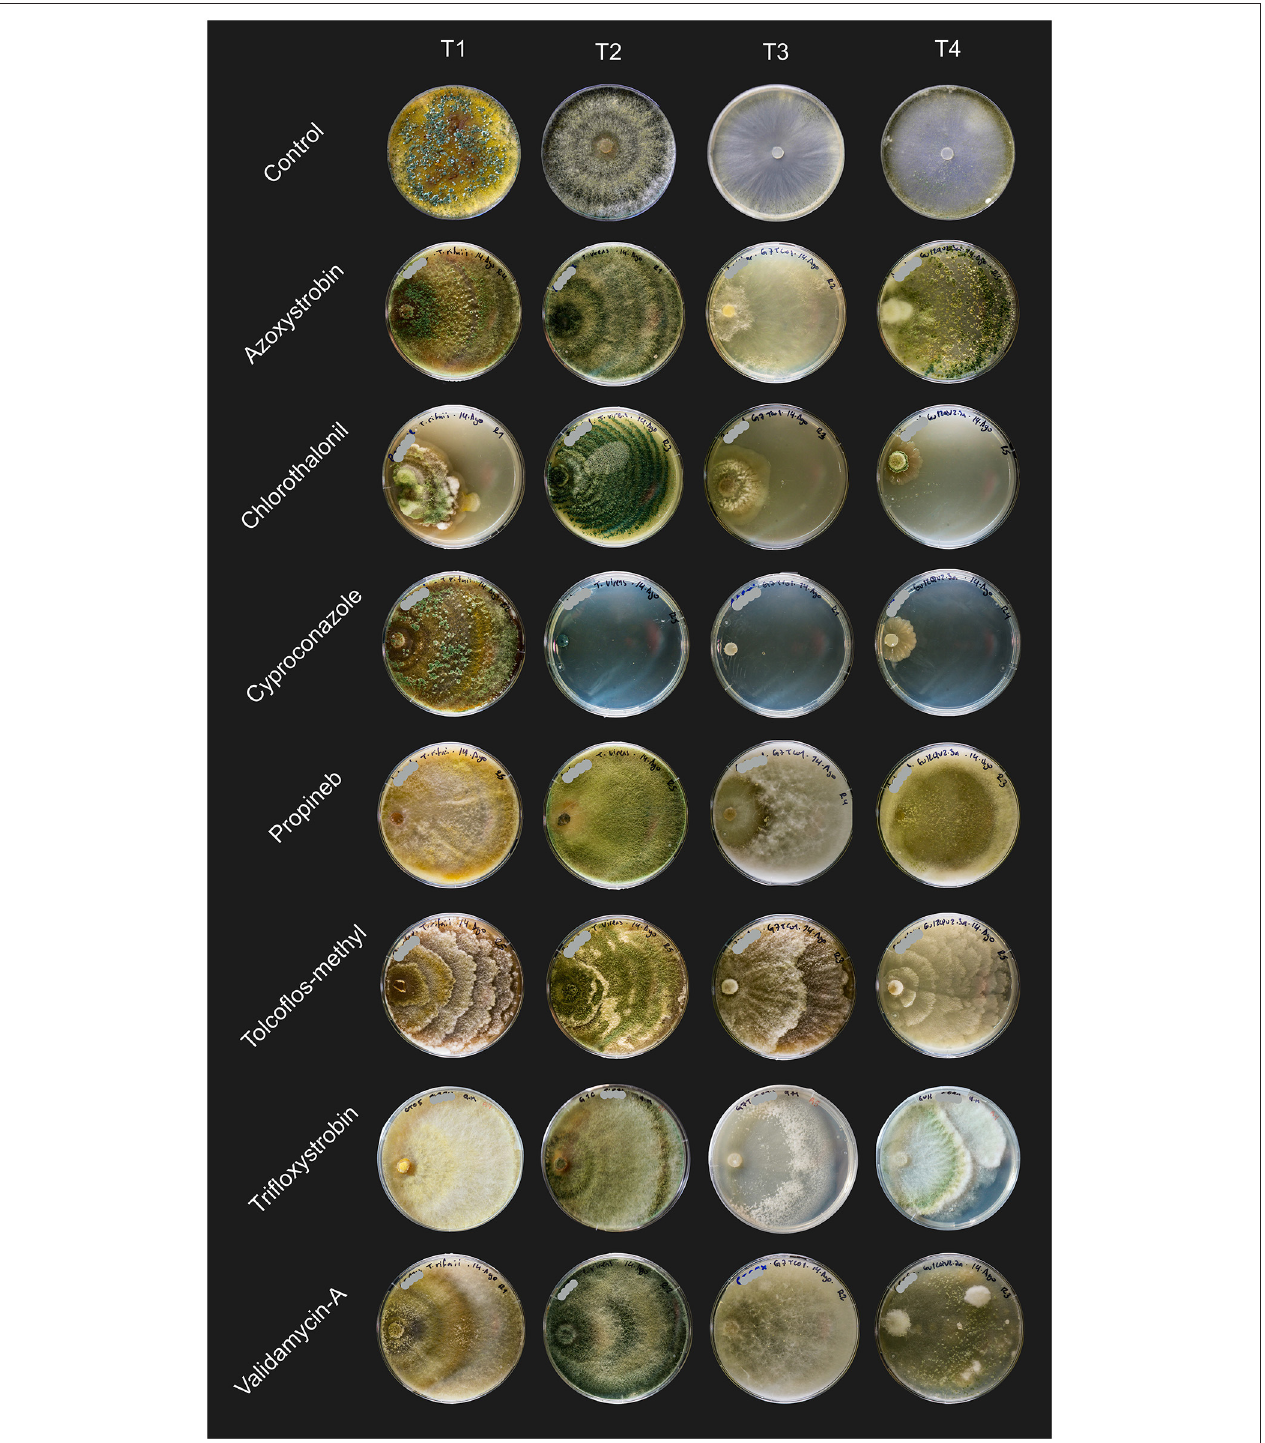
FIGURE 2 | Morphological effects of mycelial growth after 15 days. The isolates in PDA control plates are placed in the upper side of the image. Downwards, different effects on aerial mycelium can be observed in the presence of the seven fungicides. biodegradation of 59.2 and 53.6% were achieved for T1 and T4, respectively. All tested Trichoderma isolates were able to grow in presence of chlorothalonil with a dry weight greater than or equal to the control ( Figure 3B3